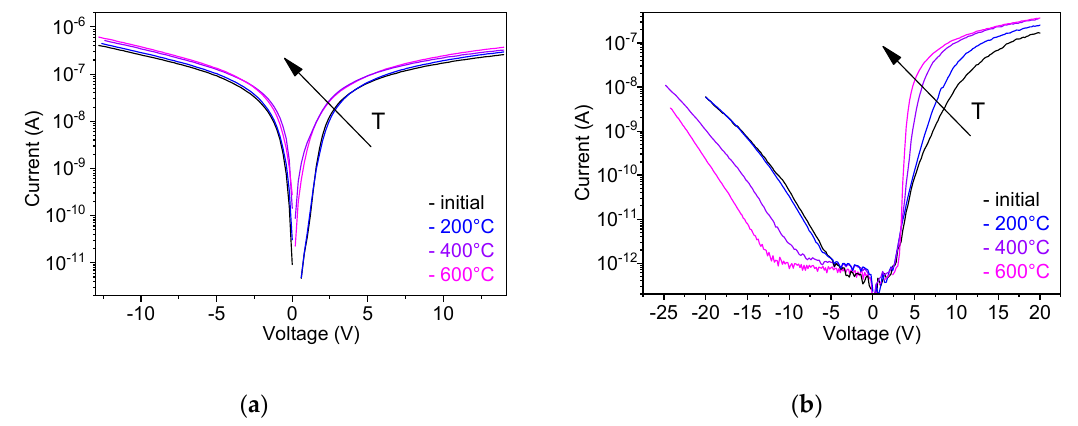
Figure 5. Semi-logarithmic I – V plots at different annealing temperatures for single nanorod n -ZnO/ p -GaN heterojunctions, ( a ) gown on the plain substrate and ( b ) FIB-patterned substrate. A significant improvement of the diode performance is observed on the FIB-patterned substrates when the annealing temperature is 400 °C or higher.